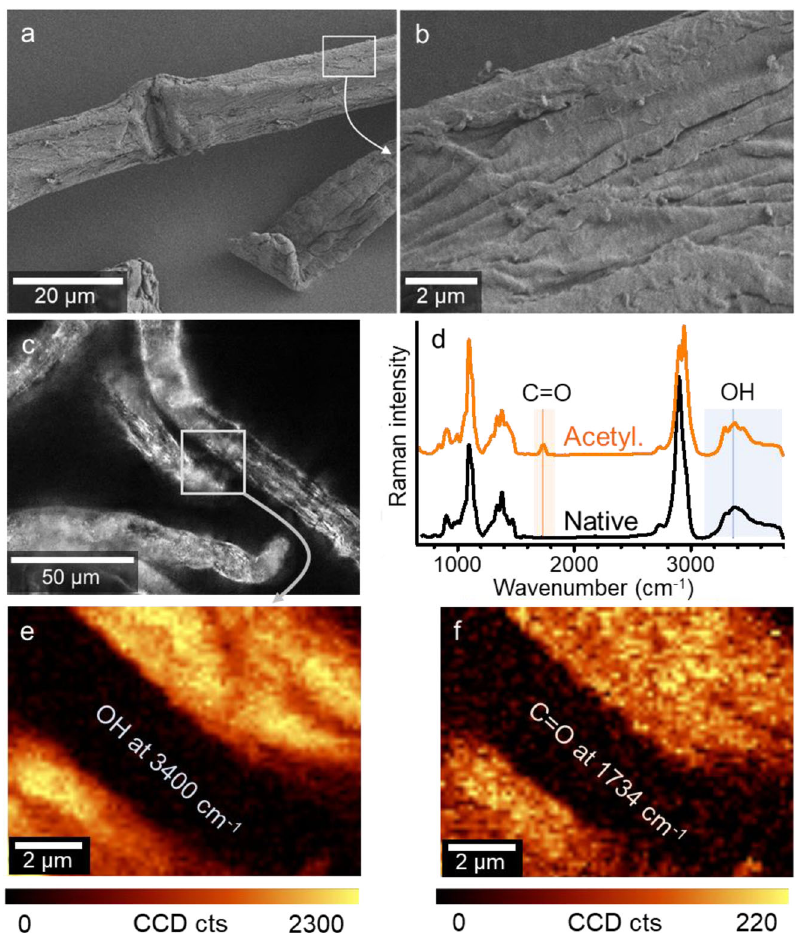
Fig. 4 Imaging of the surface of acetylated fi bres. The con fi ned water-promoted acetylation preserved the morphology of the native cellulosic fi bres, as demonstrated via scanning electron ( a , b ) and light microscopy ( c ). The carbonyl (C = O) band of the acetyl group is clearly shown in the Raman spectrum of the acetylated fi bre ( d ). Raman mapping images of the hydroxyl (OH) and C = O band ( e and f ) prove a homogeneous distribution of the acetyl groups on the cellulosic fi bre. Raman signal intensities in counts (cts), measured with a charge-coupled device (CCD) detector, are represented by the colour